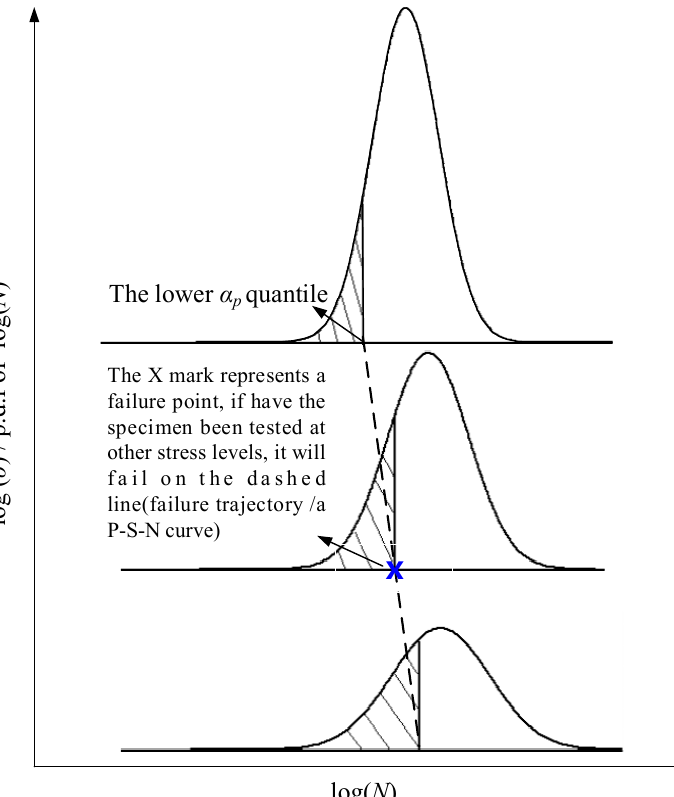
Figure 1. Fatigue life percentile consistency principle.